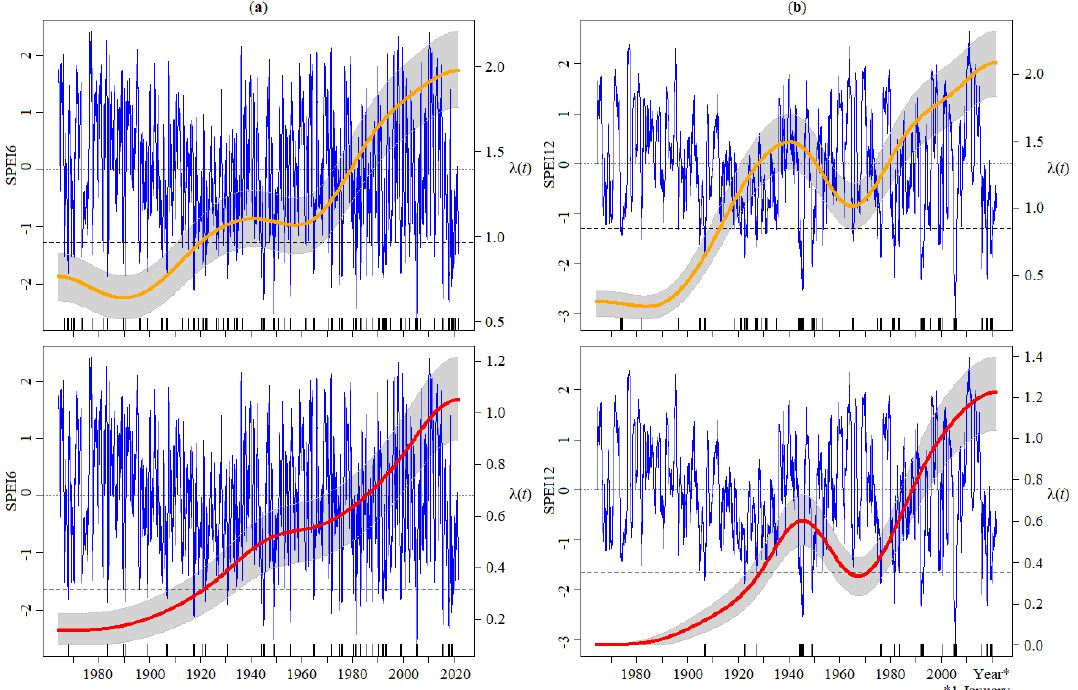
Figure 10. Time dependent occurrence rates from 1 October 1864 to 30 September 2021 of periods under drought conditions for ( a ) SPEI6 and ( b ) SPEI12: SPEI series (in blue), drought thresholds (horizontal dashed lines), number of periods under drought conditions per year, λ ( t ) , of severe (in orange, top plots) and extreme (in red, bottom plots) droughts, and confidence band (grey area). The vertical ticks represent the time data of the